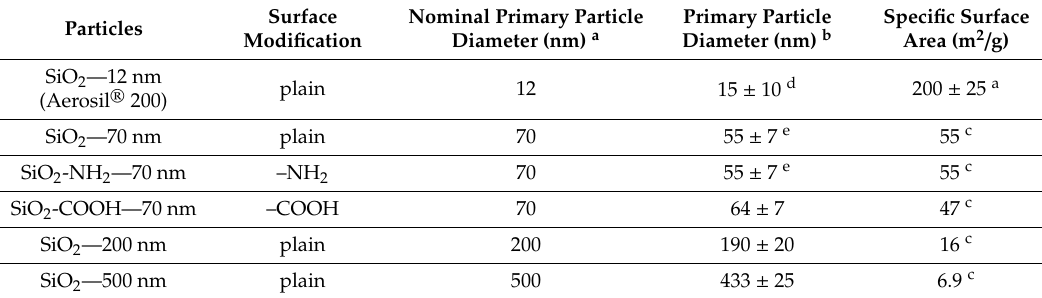
Table 1. Characteristics of silica nano- and